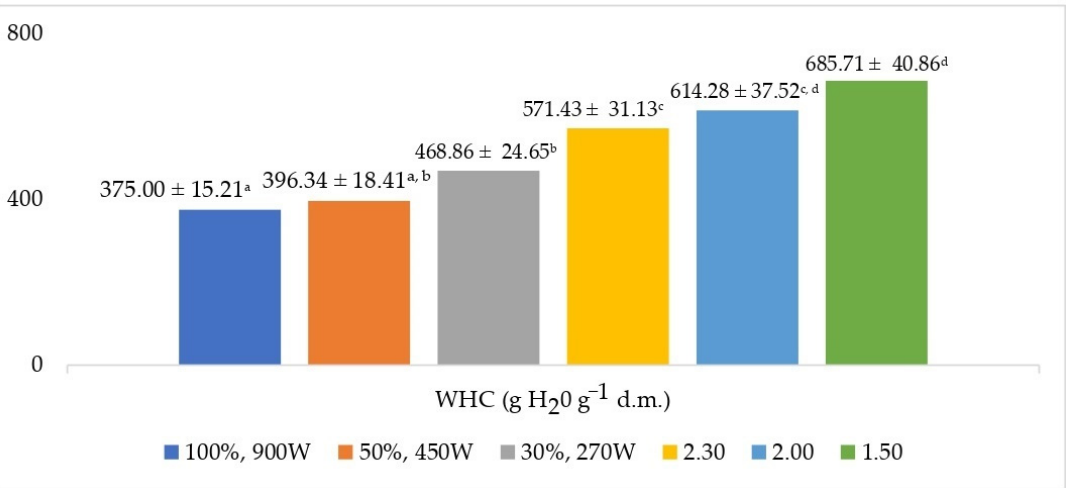
Figure 3. WHC in chokeberry obtained by two methods: MD and MCD. a–d Different letters in the superscript in Figure 3 indicate a statistically signi fi cant di ff erence between values at a signi fi cance level of p < 0.05 the post hoc Tukey HSD test).